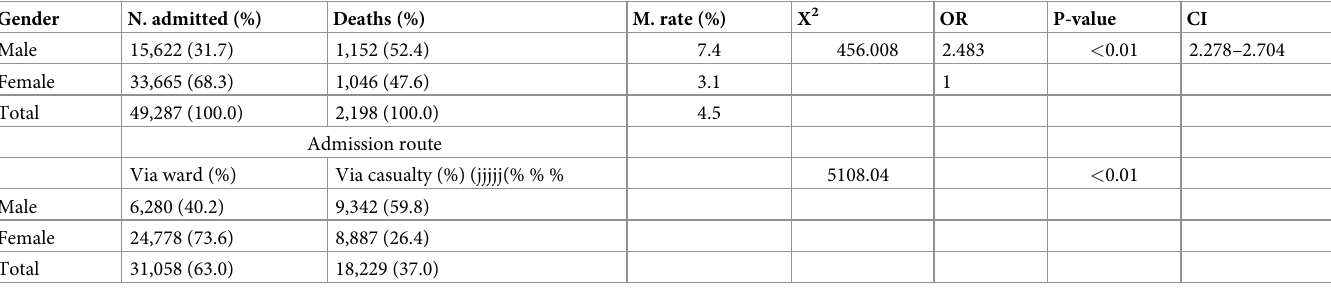
Table 1. Frequency of morbidity and mortality of the studied population based on gender.